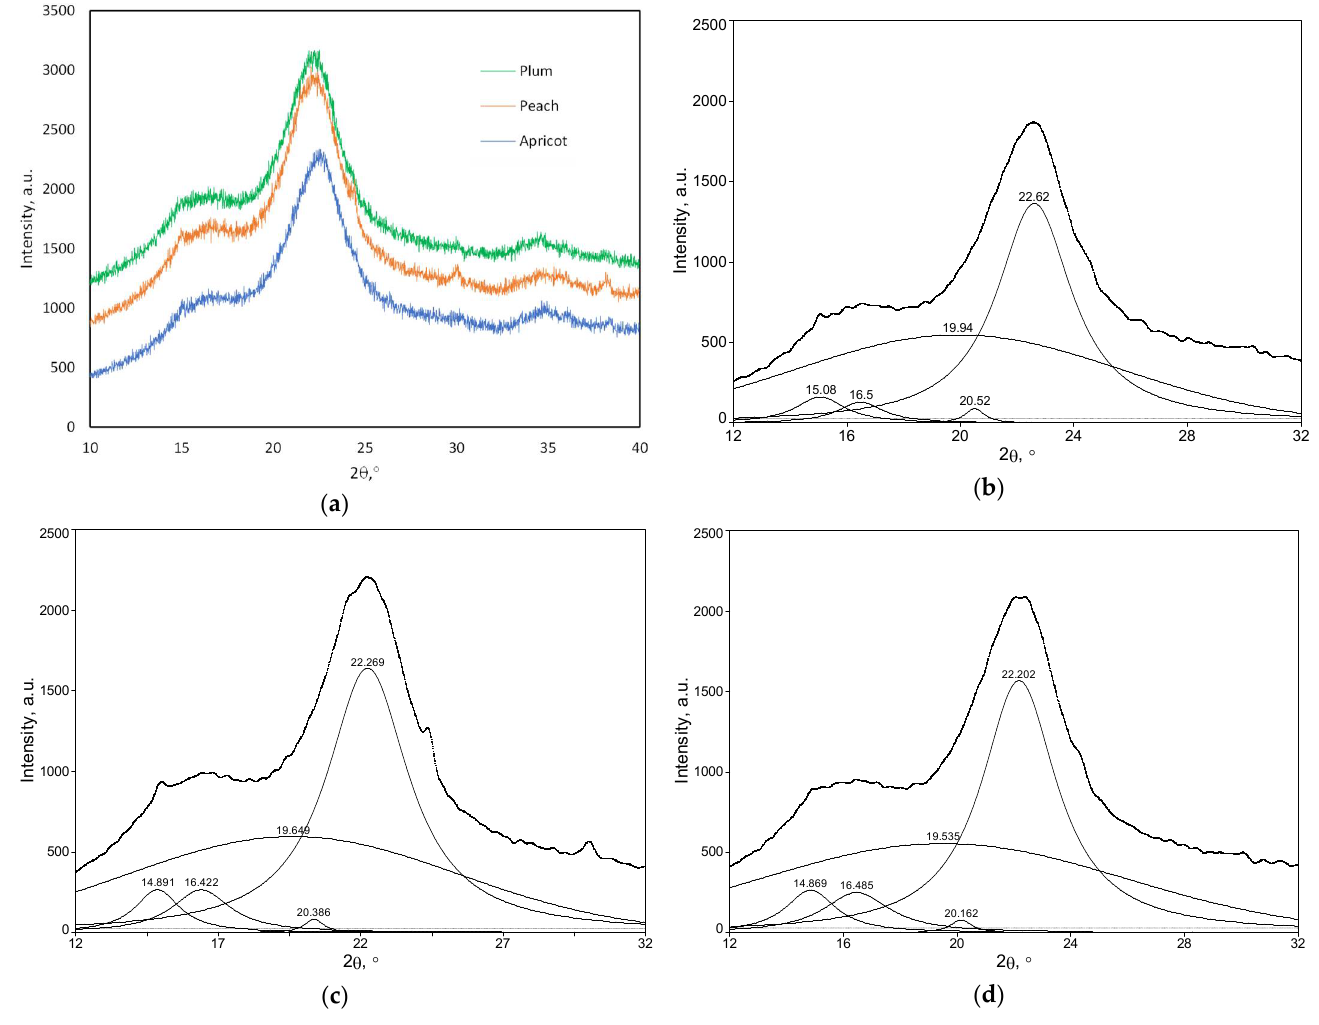
Figure 3. Unprocessed ( a ) and deconvoluted X-ray diffractograms of: ( b ) apricot, ( c ) peach, and ( d ) plum tree wood samples.